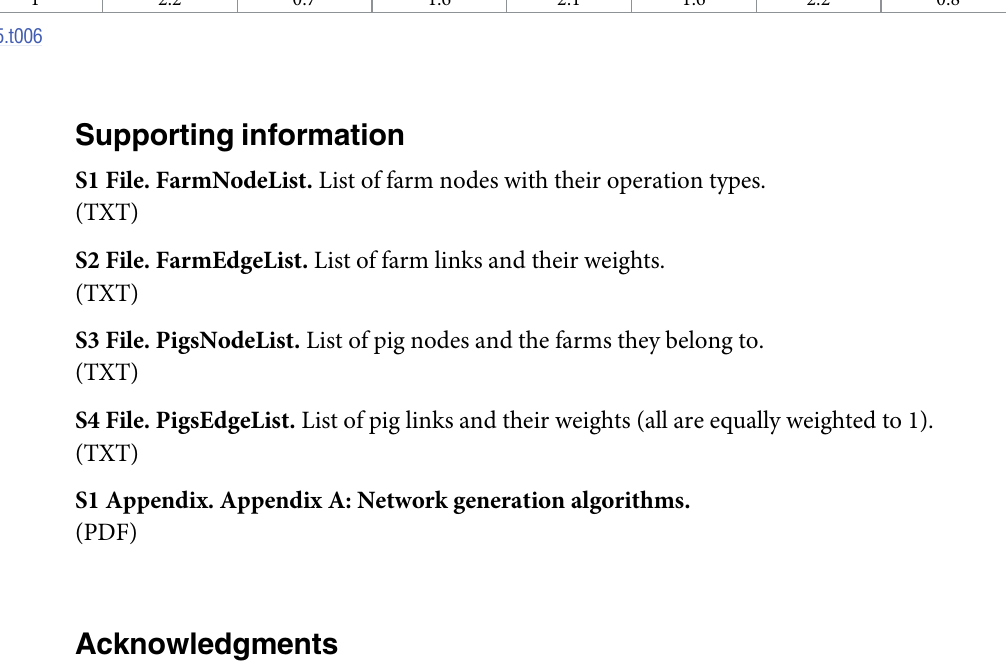
Table 6. Transmission rate estimated for 9 pig herds by Guinat et al. [28]. Herd